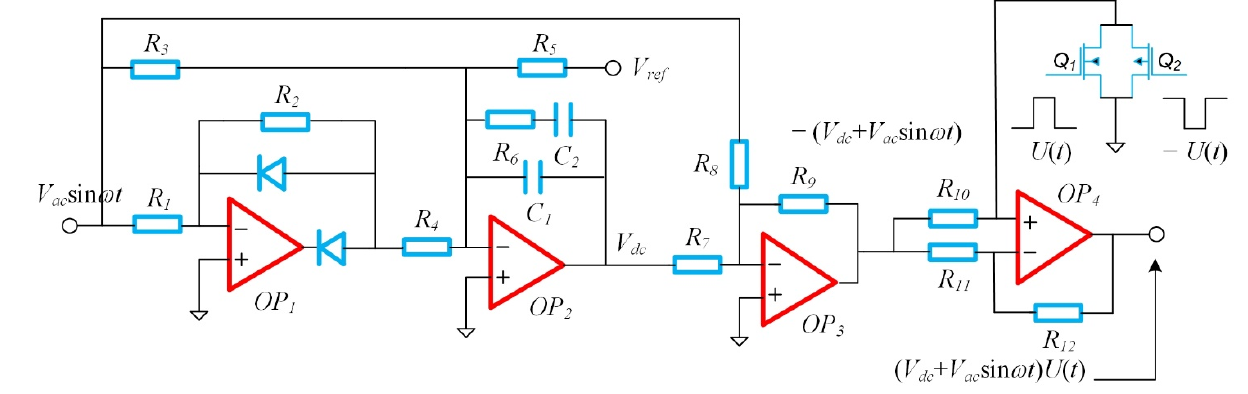
Figure 9. Principle diagram of the automatic gain-control and modulation drive circuit.